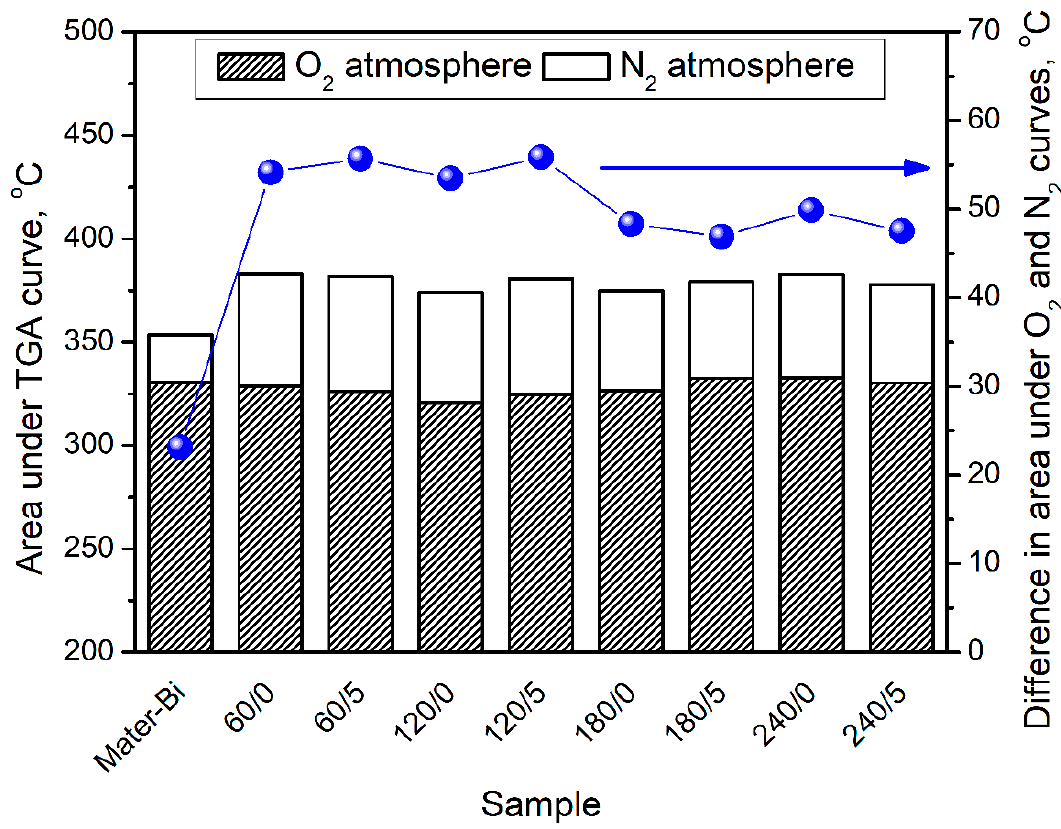
Figure 4. Results of integration of TGA curves registered for Mater-Bi and its composites.